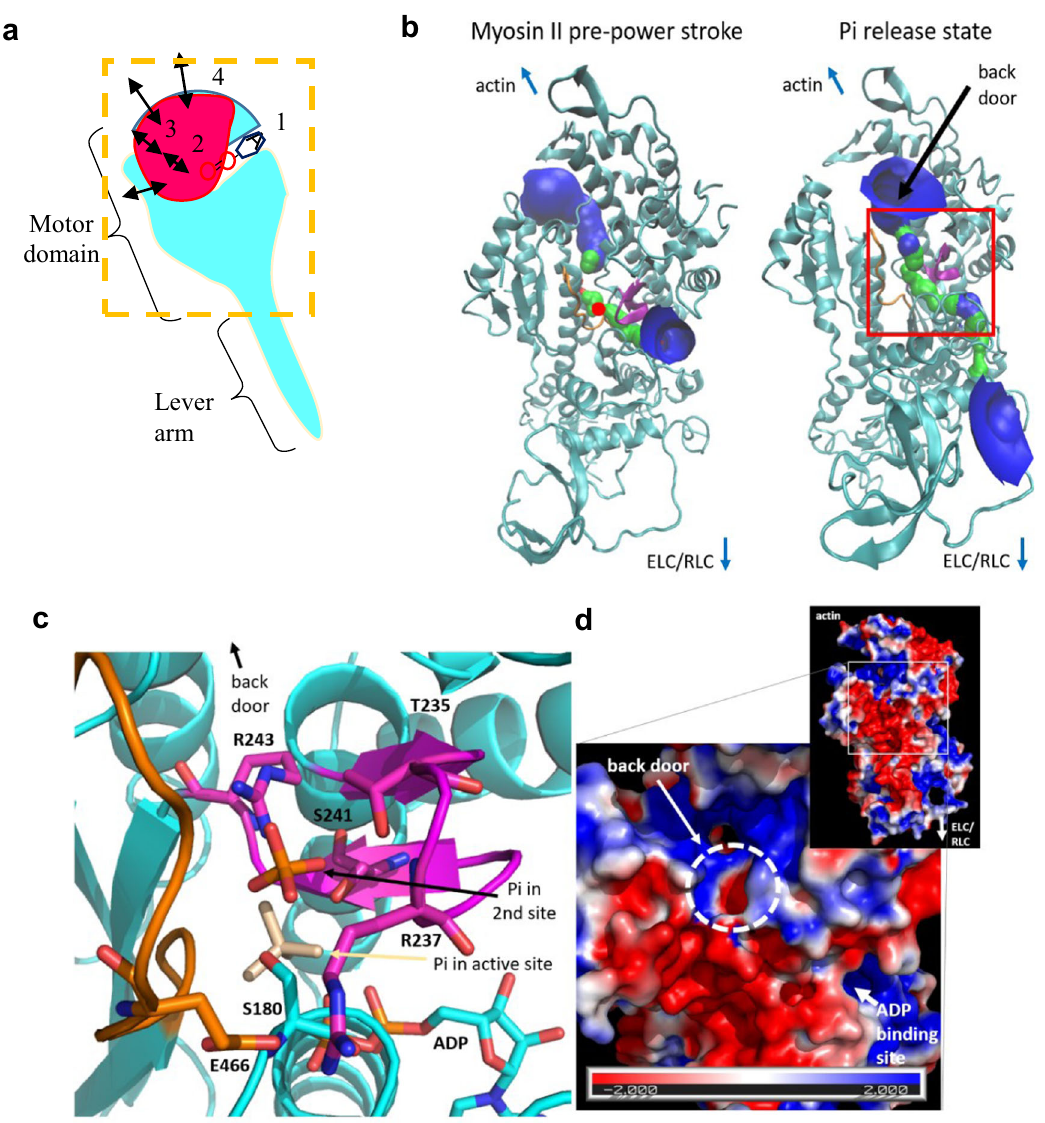
Fig.1|ModelingofPi-releaseofstriatedmuscle(cardiac)myosinII.a Schematic illustration of Pi-release from myosin subfragment 1: with binding of ATP (1),